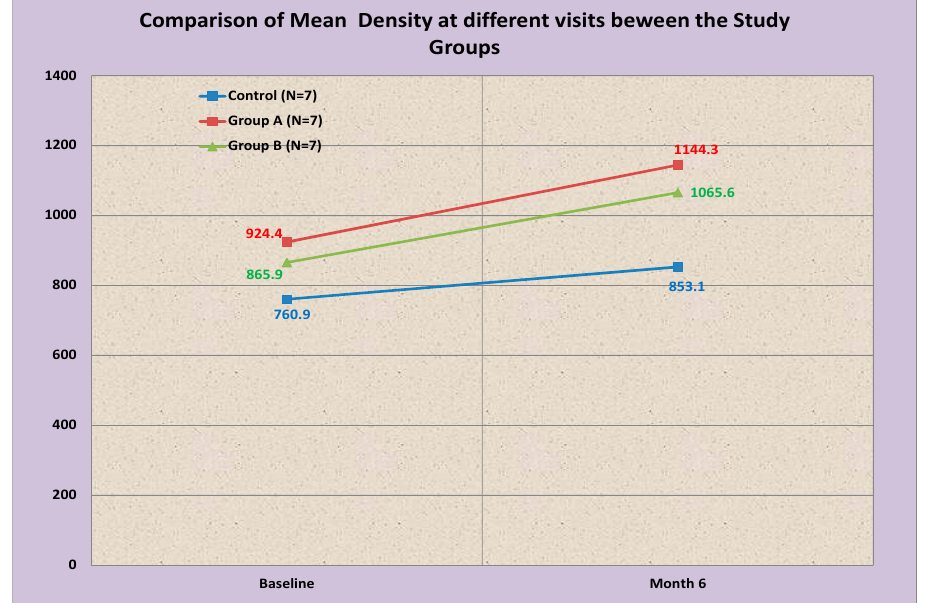
Figure 4. Comparison of Mean Density at different visits between the study groups .